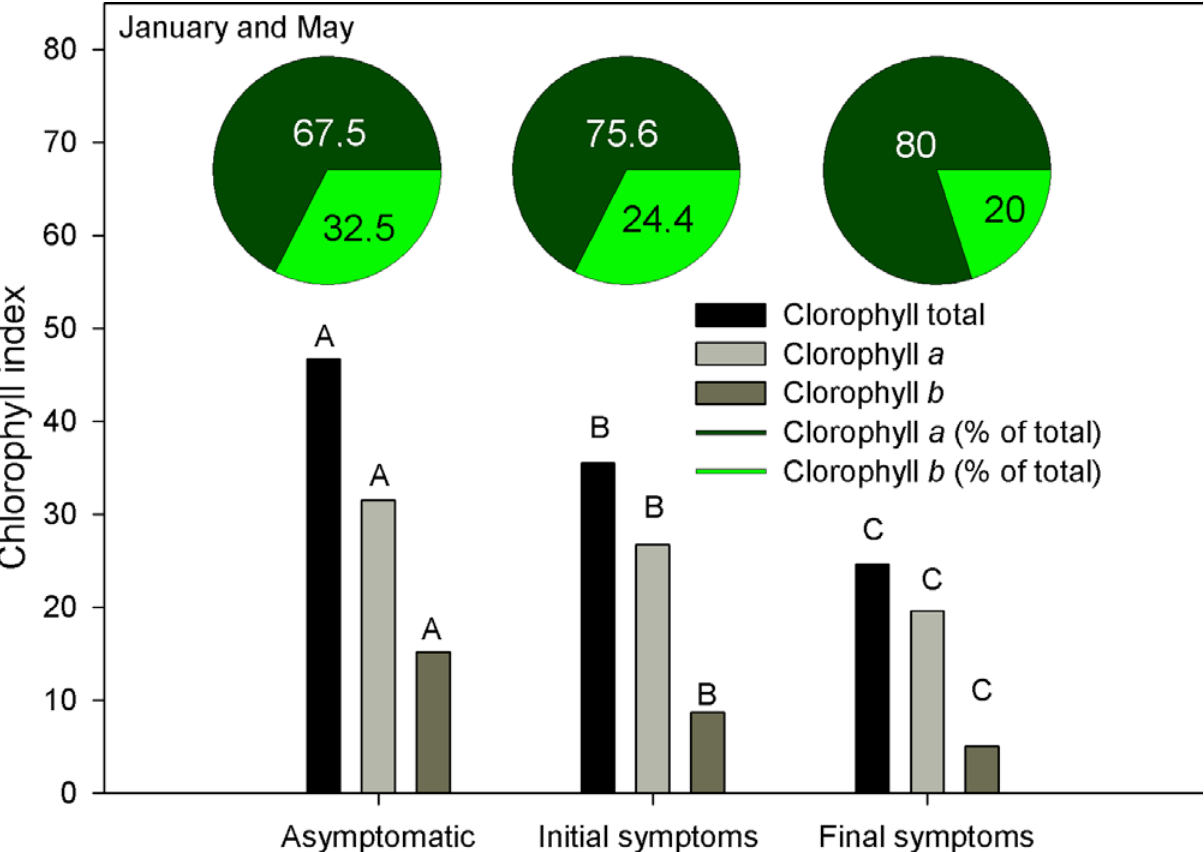
Figure 3. Chlorophyll indices from asymptomatic grapevine leaves and those with initial and final symptoms of grapevine leaf stripe disease (GLSD). Uppercase letters in columns indicate no significant differences between treatments in total chlorophyll, chlorophyll A and chlorophyll B by Tukey test ( P =